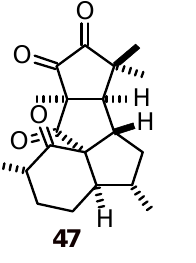
Figure 4. Structures of diterpenes 47 and 48